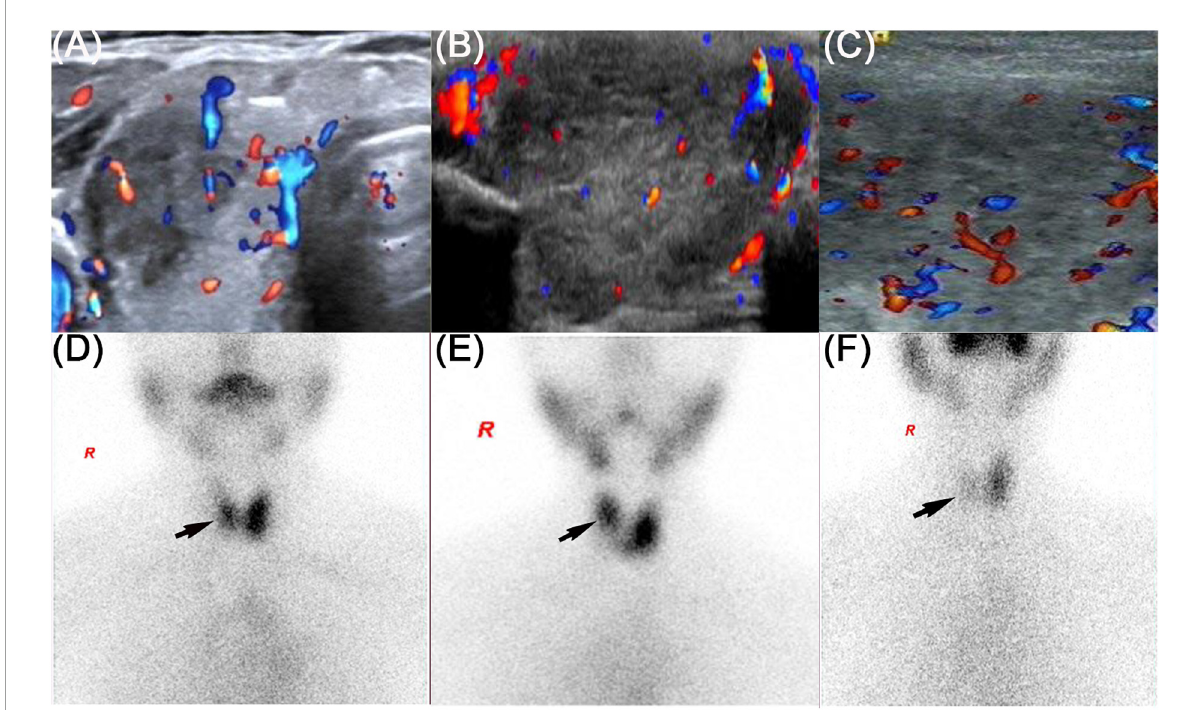
FIGURE1 Thyroid ultrasound and thyroid emission computed tomography of three patients. The black arrow showed the radioactive distribution defects in the thyroid lobe. (A,D) Refers to patient 1, (B,E) refers to patient 2, and (C,F) refers to patient 3.